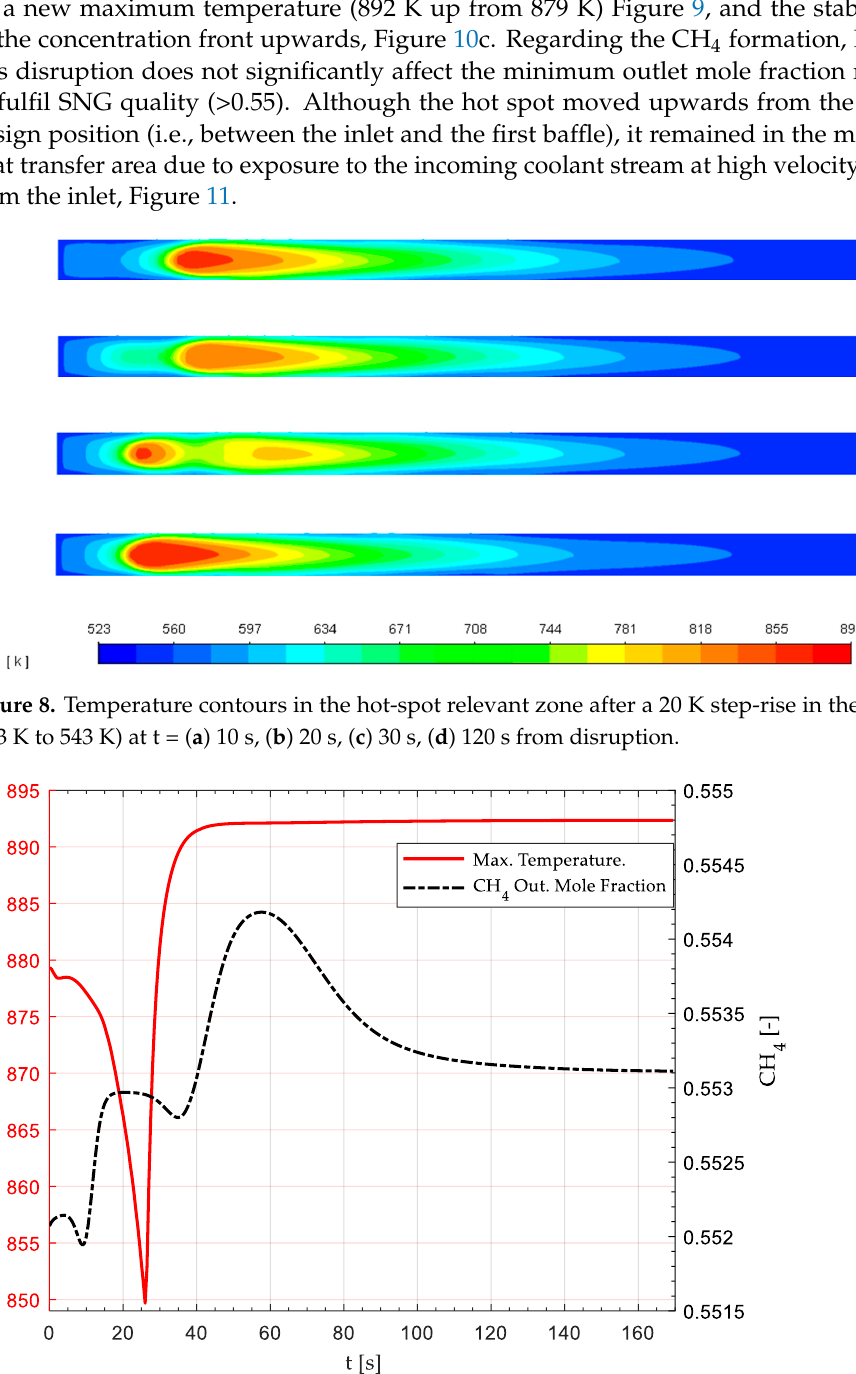
Figure 9. Effect of a 20 K step-rise in the feed gas (523 K to 543 K) on the maximum (Hot Spot) reactor temperature and CH 4 average outlet mole fraction. The disruption begins at t = 0, and a new steady state is established after t ≈ 120 s.